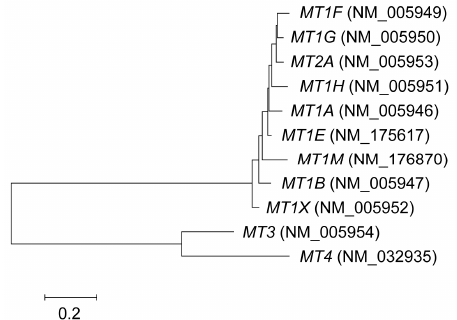
Figure 2. Phylogenetic tree of MT genes. The tree was constructed using coding sequences from NCBI RefSeq and the neighbor-joining method using MEGA6 software.